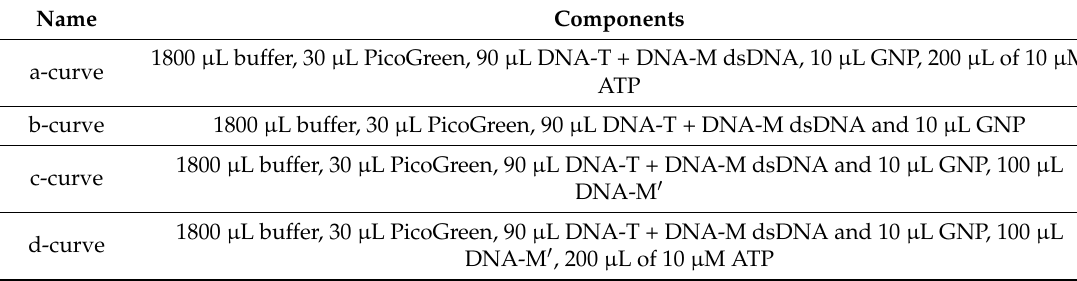
Table 4. Components in the experiment of Figure 1.